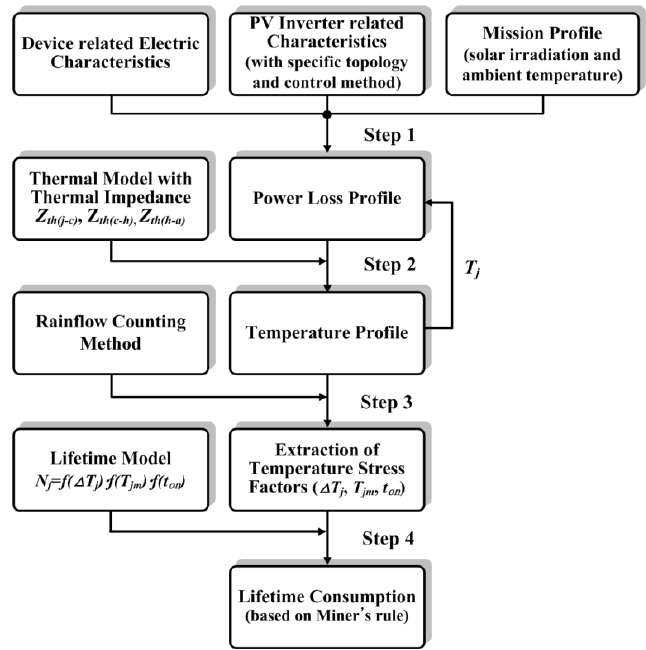
Figure 9. Lifetime evaluation procedure of the power devices in the PV inverter.